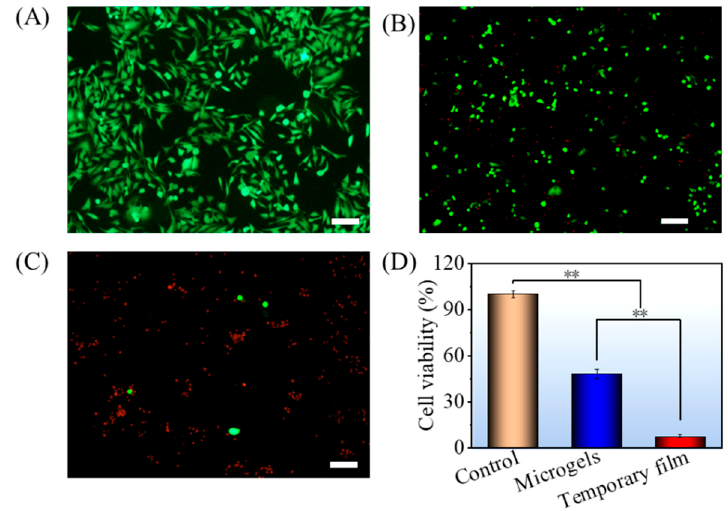
Figure 9. Antitumor activities of the PCD film (control), microgels, and temporary film after incu- bation for 24 h. The microgels and temporary film were heated at 45 °C for 10 min after the initial 24 h drug release. ( A – C ) Live (green)/dead (red)-stained Hela cells for control ( A ), microgels ( B ), and temporary film ( C ). Scale bar: 100 μ m. ( D ) Cytotoxicity to Hela cells. Significance was defined as ** p < 0.01, n = 5.